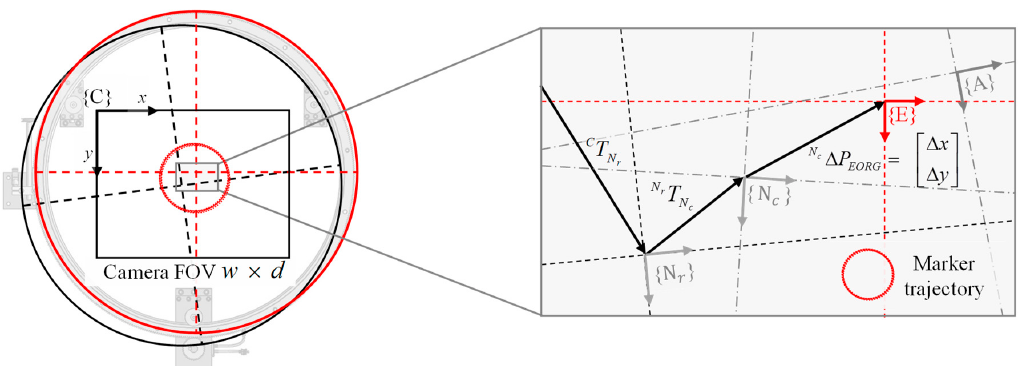
Figure 6. Schematic of the in-plane center alignment error (IPCA) of the circular motion slide (CMS), due to the uncertain assembly of the eccentric typed bearing.